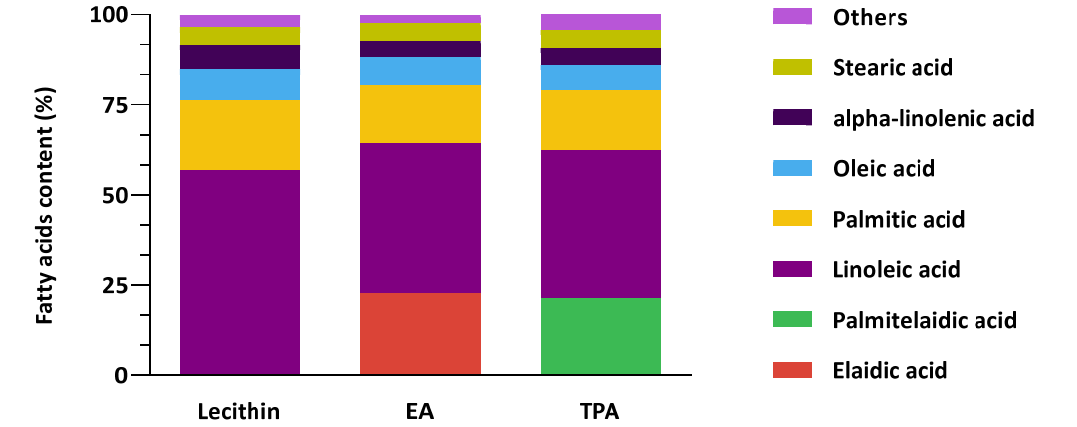
Figure 1. The fatty acids composition of control vesicle (Lecithin) and elaidic acid (EA) or trans - palmitoleic acid (TPA)-enriched vesicles.